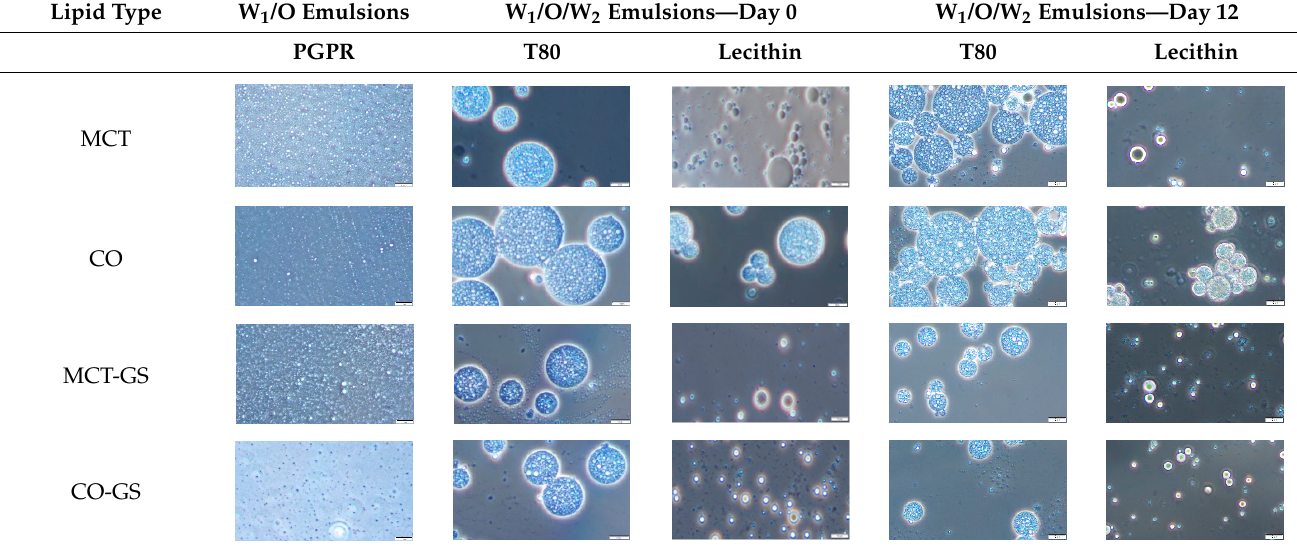
Table 3. Optical microscopy images of chlorophyllin-loaded W 1 /O emulsions (day 0) and W 1 /O/W 2 (day 0 and 12) formulated with different lipid phases consisting on medium chain triglyceride (MCT) or corn oil (CO) and without or with glyceryl stearate (GS) as well as different hydrophilic surfactants (Tween 80 (T80) or Lecithin). Scale bar: 10 µ m. Lipid Type